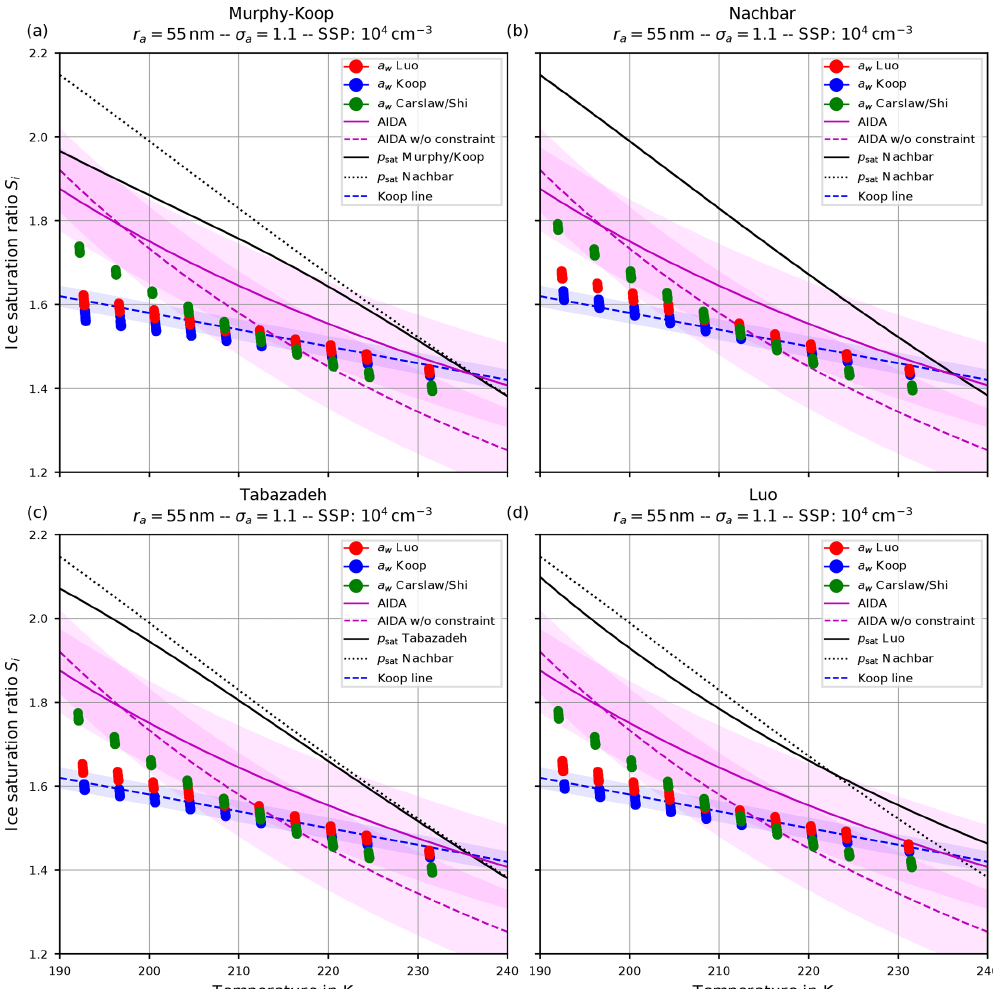
Figure 11. Ice onset as a function of temperature for the same scenarios as in Fig. 9 with the choice σ a = 1 . 1 for the dry aerosol lognormal size distribution and the ice activity evaluated by the quotient p i , sat (see Eq. 3). The format of the panels is as in Fig. p sat